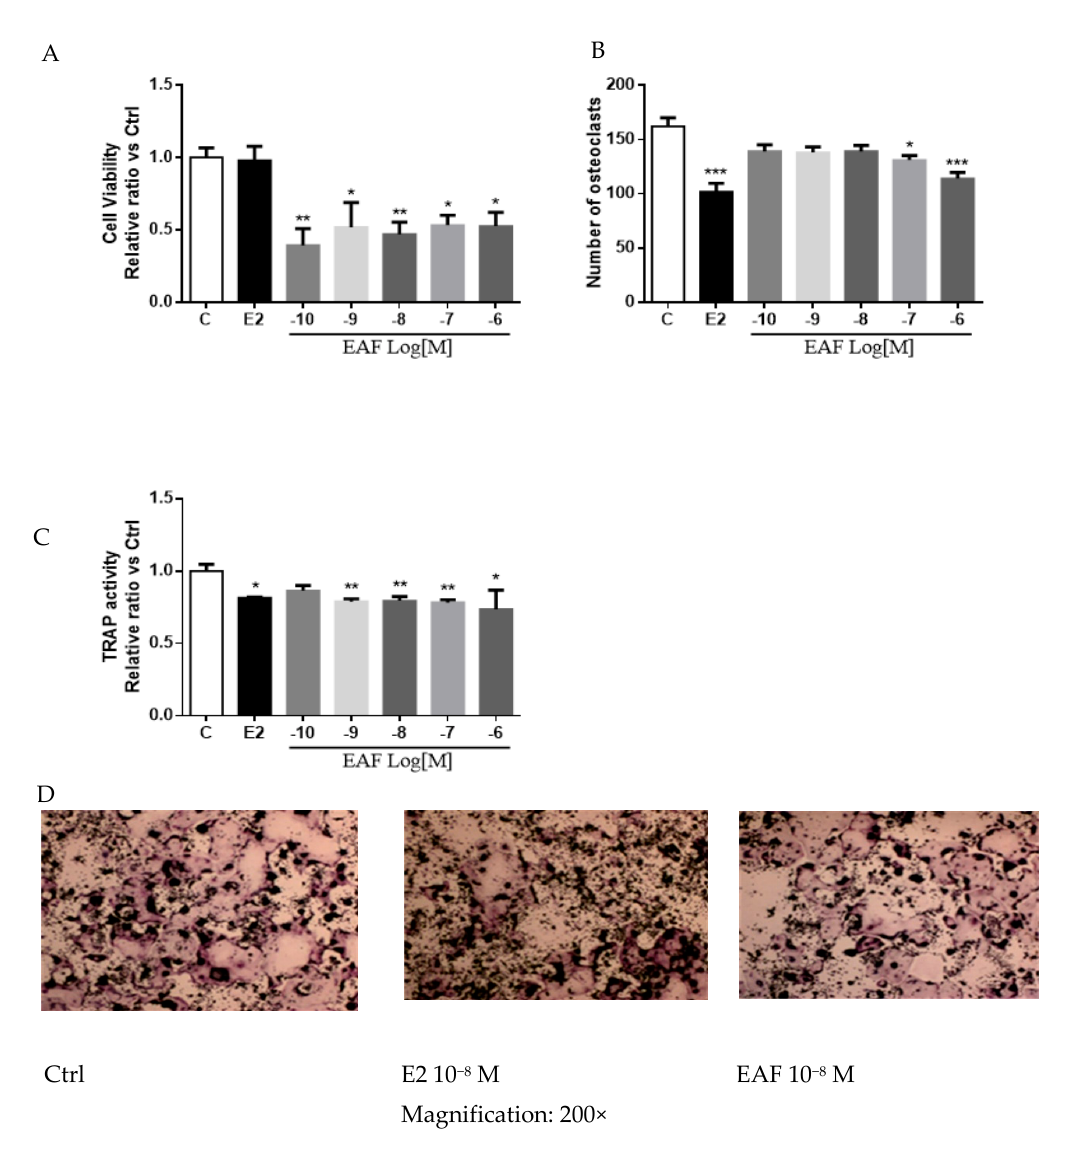
Figure 5. EAF decreased cell viability ( A ), reduced number of tartrate resistant acid phosphatase (TRAP) stained multinucleated cells ( B ) and TRAP activities ( C ) in Receptor Activator of NF- κ B Ligand (RANKL)-induced RAW264.7 cells. ( D ) The representative TRAP staining of RANKL-induced RAW 264.7 cells.